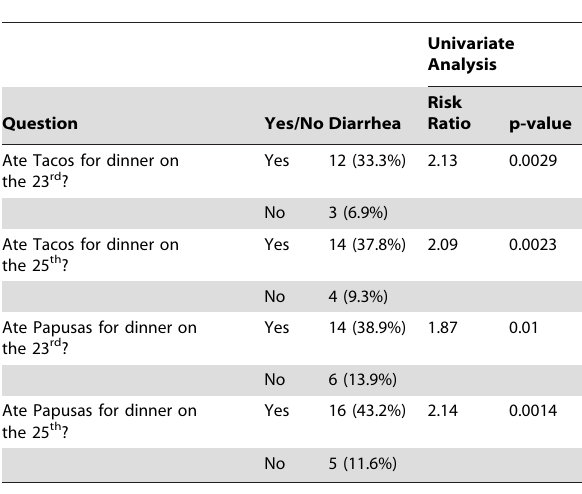
Table 3. Food Consumption among three units with highest incidence of diarrheal disease